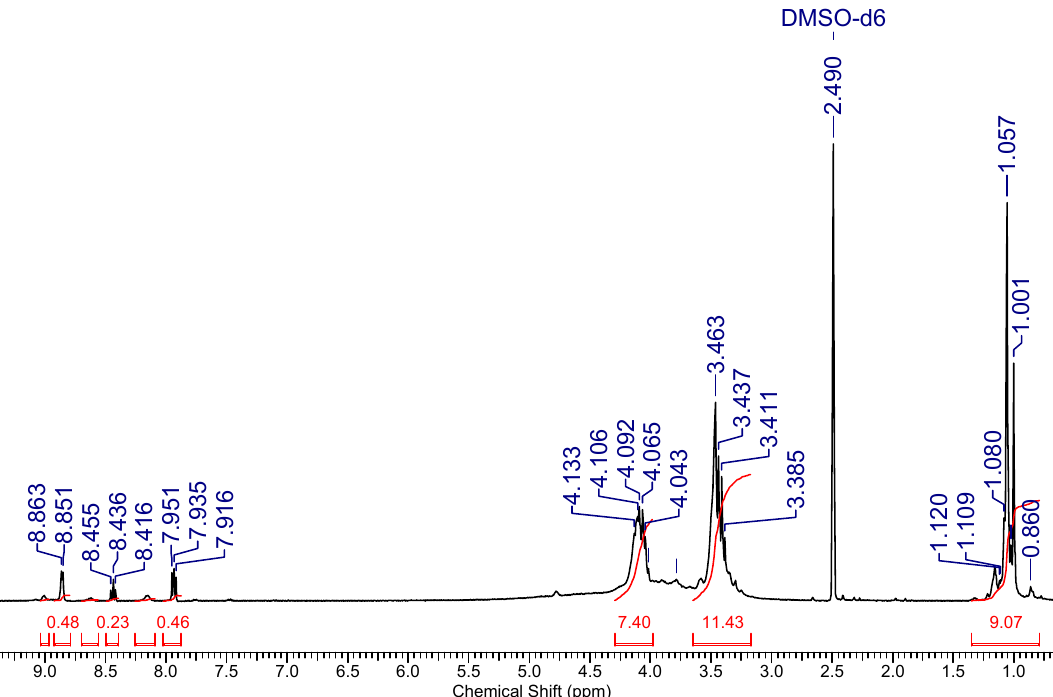
Figure 1. The NMR 1 H spectrum of pyridinium product 4 (400 MHz, DMSO-d 6